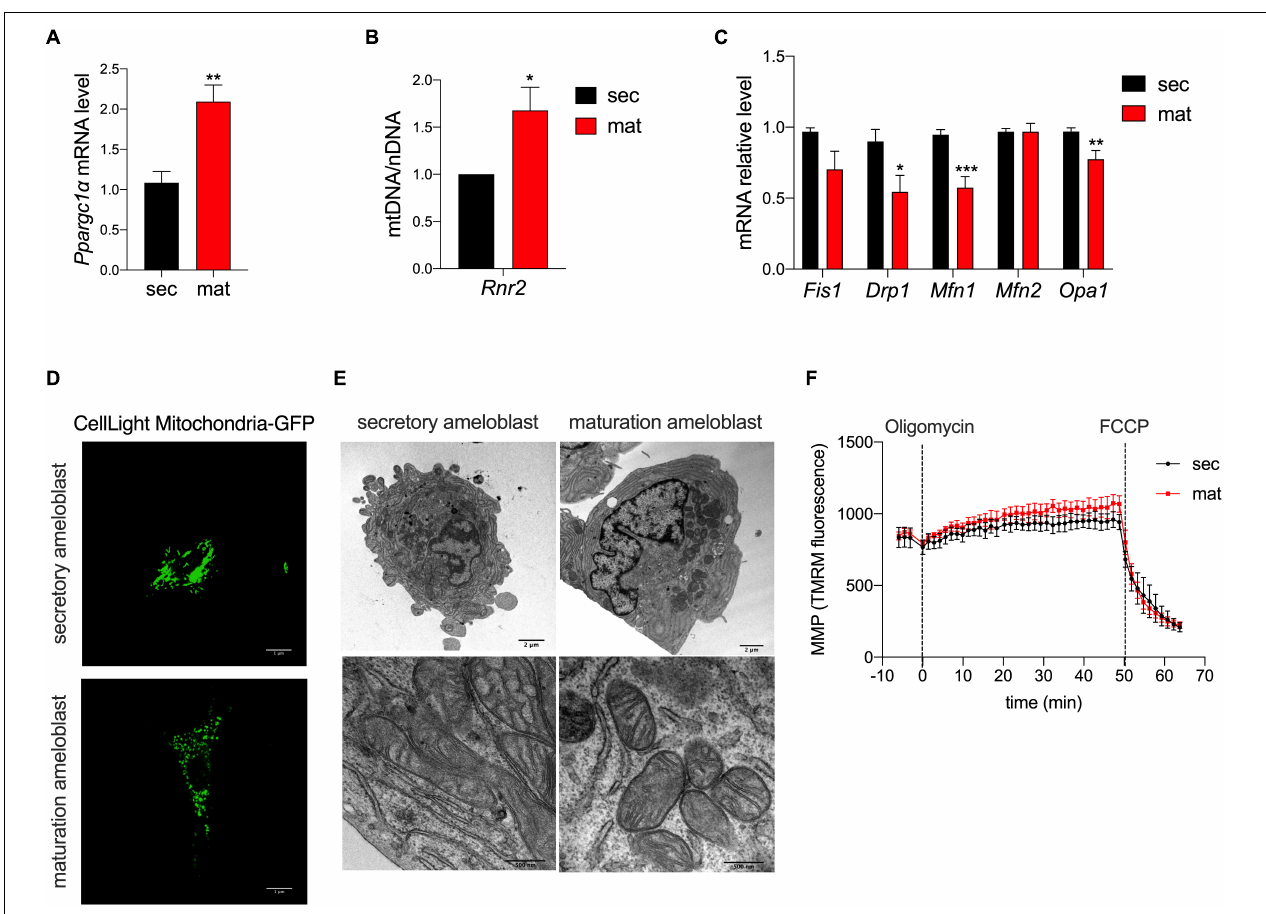
FIGURE 1 | Mitochondrial morphology and biogenesis but not membrane potential differ in amelogenesis. (A) RT-qPCR analysis of peroxisome proliferator-activated receptor gamma coactivator 1-alpha ( Pparcg1 α ), a marker for mitochondrial biogenesis revealed upregulation of its mRNA in maturation. (B) RT-qPCR analysis of Rnr2 (16S ribosomal RNA), a marker for mitochondrial DNA, which was normalized to Gapdh as a reference for nuclear DNA, show an increase in maturation. (C) RT-qPCR analysis of mitochondrial pro-fission ( Fis1, Drp1 ) and pro-fusion ( Mfn1, Mfn2, Opa1 ) factors show a decrease in their mRNA expression in maturation cells. (D) Mitochondrial morphology assessment using CellLight Mito-GFP show increased mitochondrial fragmentation in maturation (scale bar = 1 µ m). (E) Transmission Electron Microscopy (TEM) micrographs further show the range of mitochondria shape and size which are present in secretory (left panel) and maturation cells (right panel) (scale bar = 2 µ m). (A–C) Data represent mean ± SEM from at least n = 3–6 independent experiments (* P < 0.05, ** P < 0.005, *** P < 0.001, two tailed unpaired Student’s t -test). (F) Mitochondrial membrane potential (MMP) measured using TMRM show similar values in secretory and maturation EO